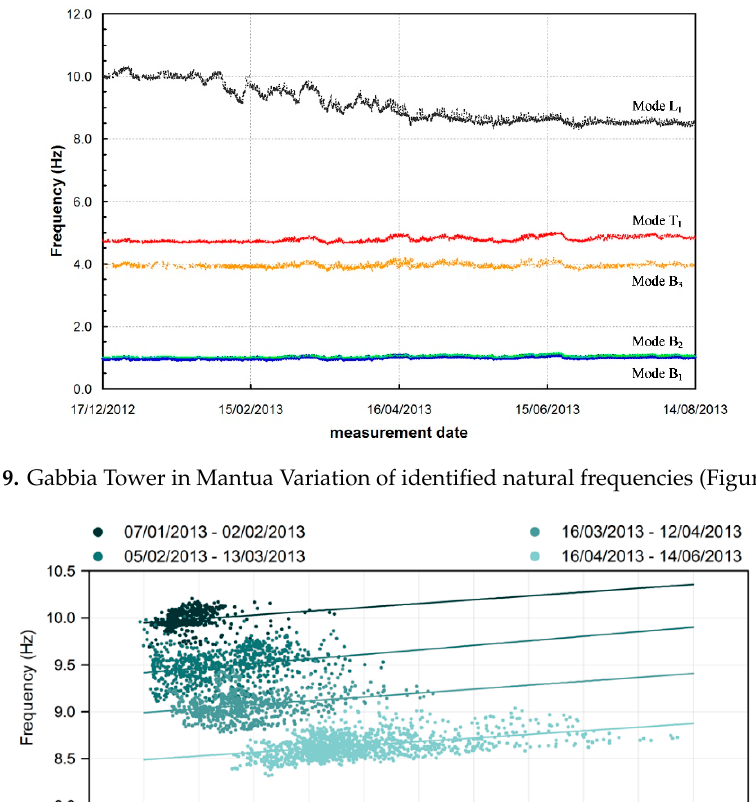
Figure 8. Carrobiolo Bell Tower in Monza: ( a ) Microwave interferometer (IDS, model IBIS-S); ( b ) Radar position in the dynamic test of the tower; ( c ) Mode shape ( Φ ) associated to the fundament frequency ( f = 1.93 Hz, ambient excitation) [20].